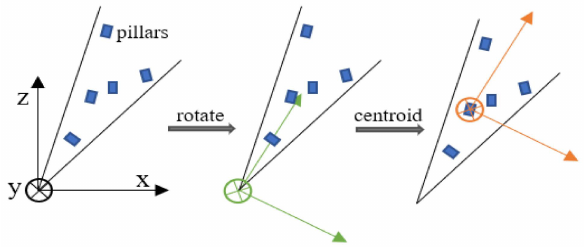
Figure 11. The frustum rotates in the direction.